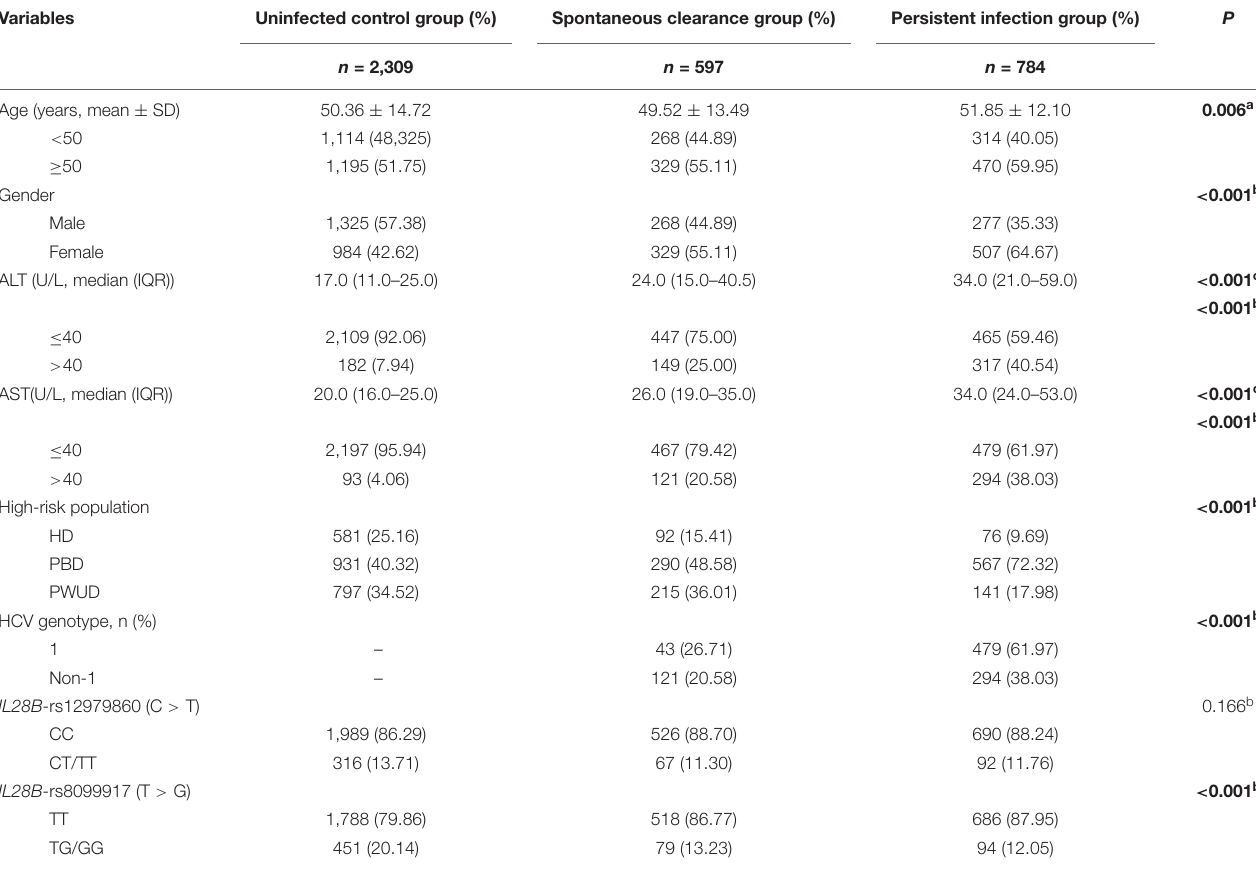
TABLE 1 | Demographical and clinical characteristics of the HCV control, spontaneous clearance, and persistent infection populations. Variables Uninfected control group (%) Spontaneous clearance group